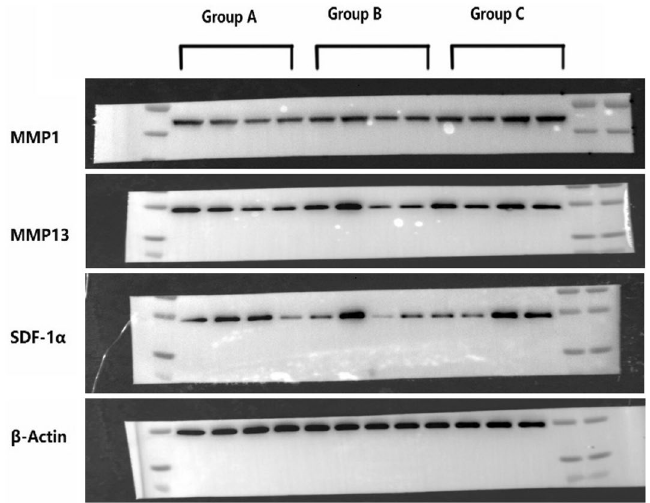
Figure 7. Western blot results(4 samples from each group) . Group C demonstrated the highest levels of MMP1, MMP13 and SDF-1α protein expression among the groups. Full-length blots/gels are presented in Supplementary Fig. 7.